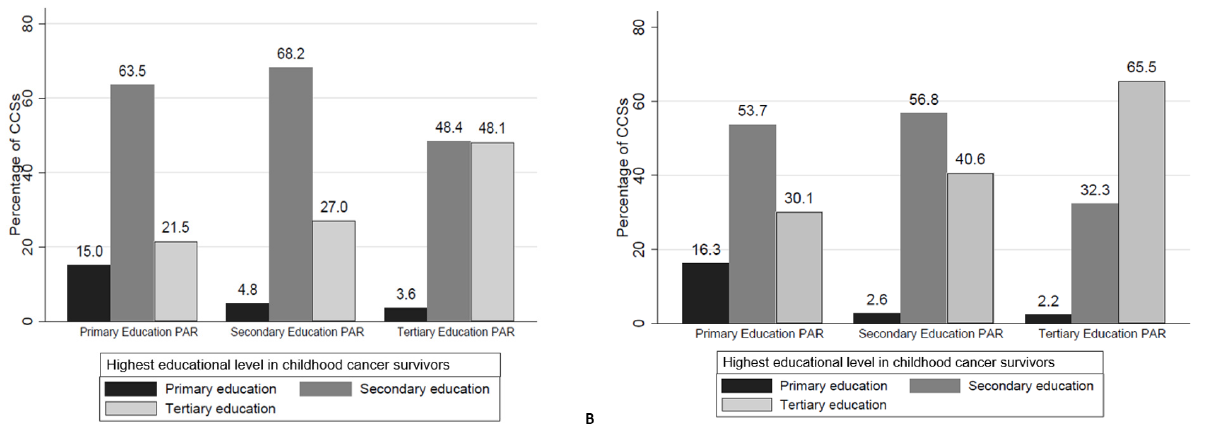
Figure 1. Highest educational level in childhood cancer survivors, represented as bars, stratified by